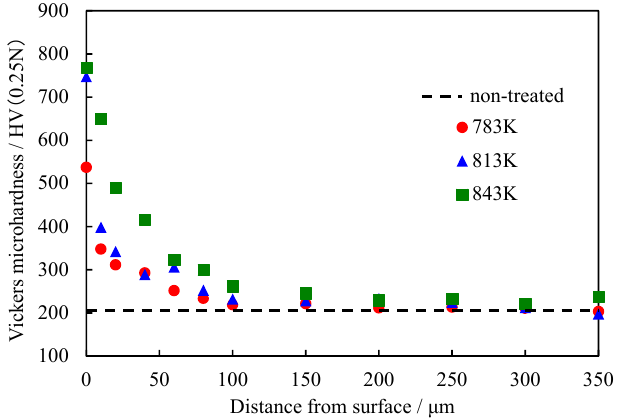
Figure 7. Cross-sectional hardness of ASPN-treated plate samples.